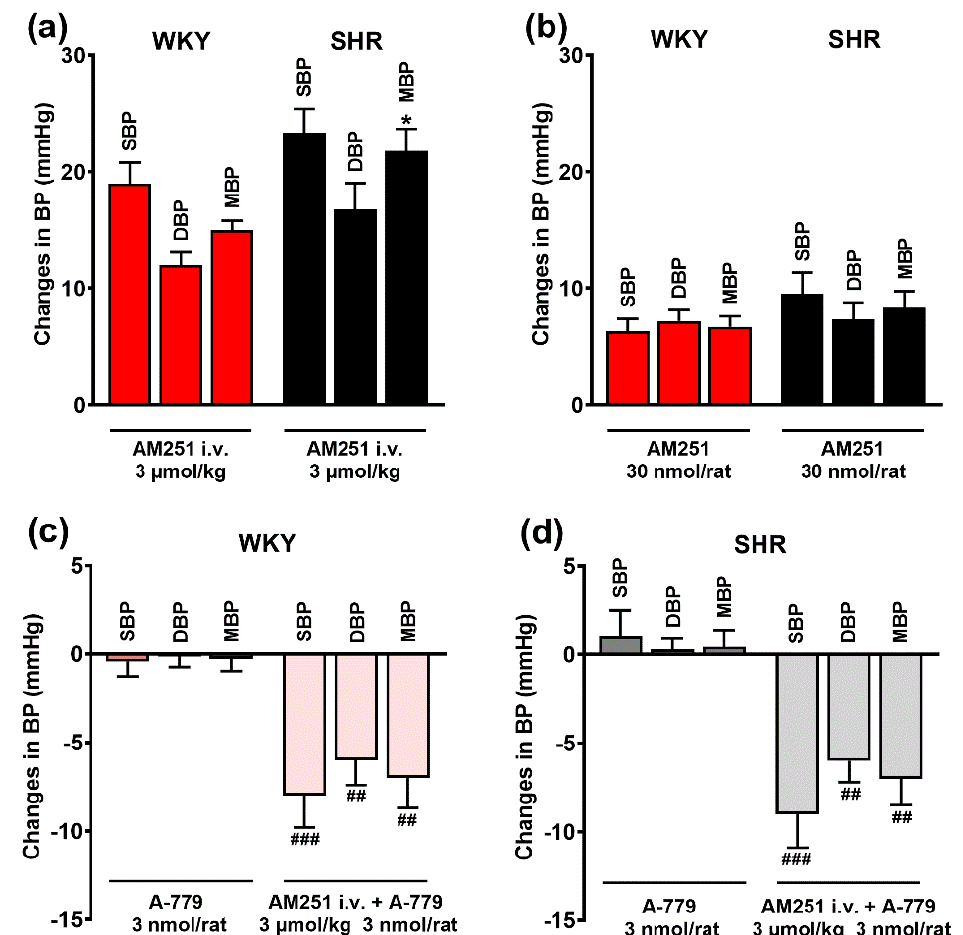
Figure 2. Effects of AM251 and A-779 on basal systolic (SBP), diastolic (DBP) and mean (MBP) blood pressure in conscious Wistar Kyoto (WKY) and spontaneously hypertensive rats (SHR). CB 1 receptor antagonist AM251 was injected intravenously ( a ) or into the paraventricular nucleus of hypothalamus (PVN) ( b ). Mas receptor antagonist A-779 was injected into the PVN. Results are presented as mean ± SEM ( n = 21–27 for A; n = 10 for B; n = 6–7 for ( c ) and ( d ). * p < 0.05 compared to WKY; ## p < 0.01, ### p <0.001 compared to A-779 in the absence of AM251.